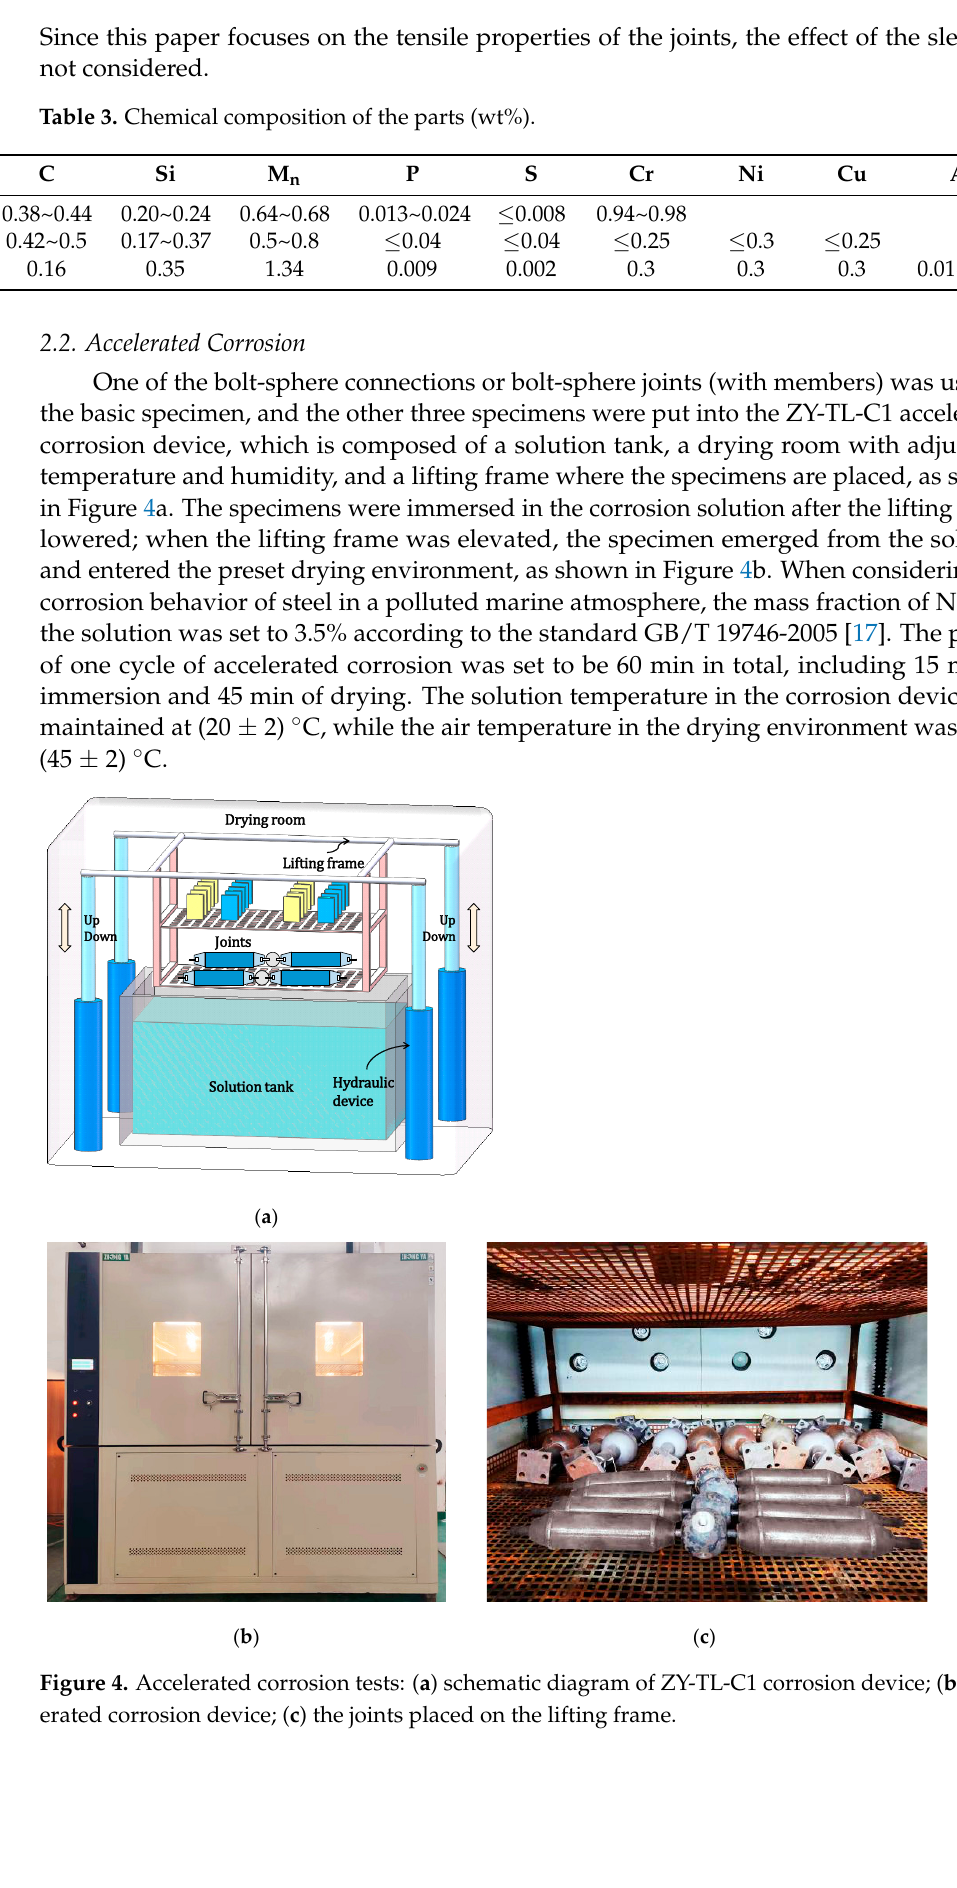
Table 3. Chemical composition of the parts (wt%).